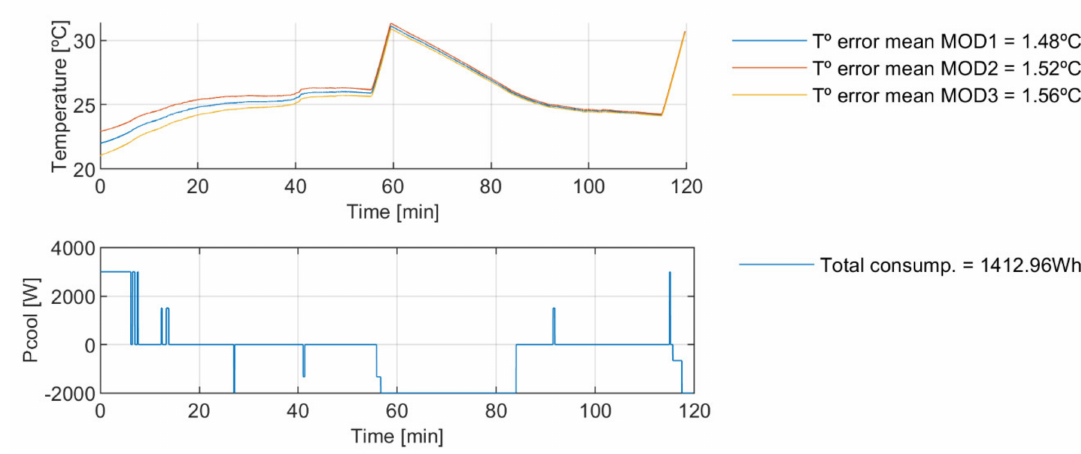
Figure 12. Use case simulation with the developed K-nearest neighbour-based controller.